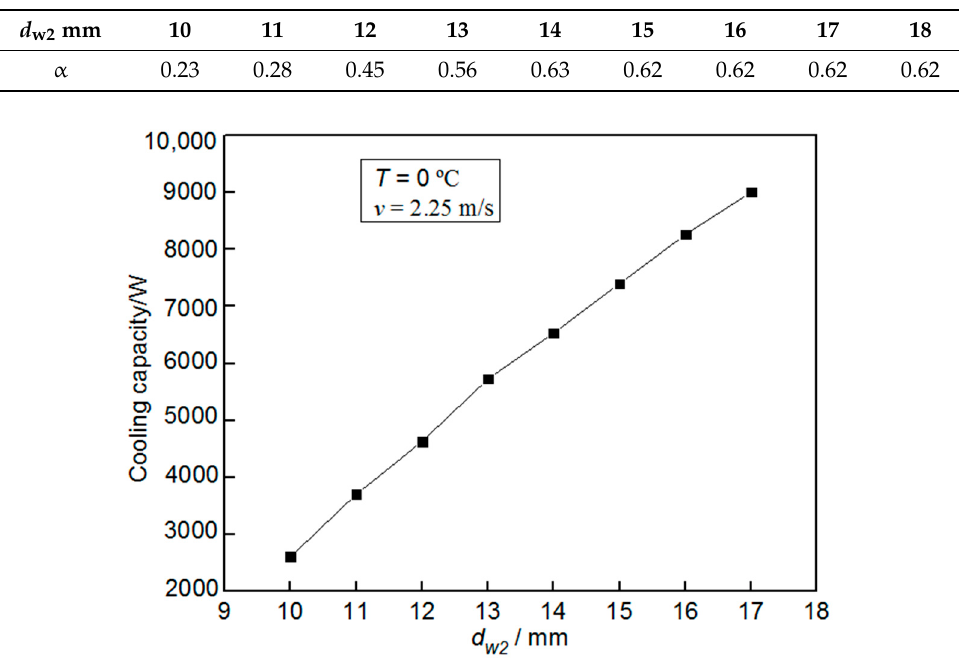
Figure 14. Effect of d w2 on cooling capacity. Figure 14. E ff ect of d w2 on cooling